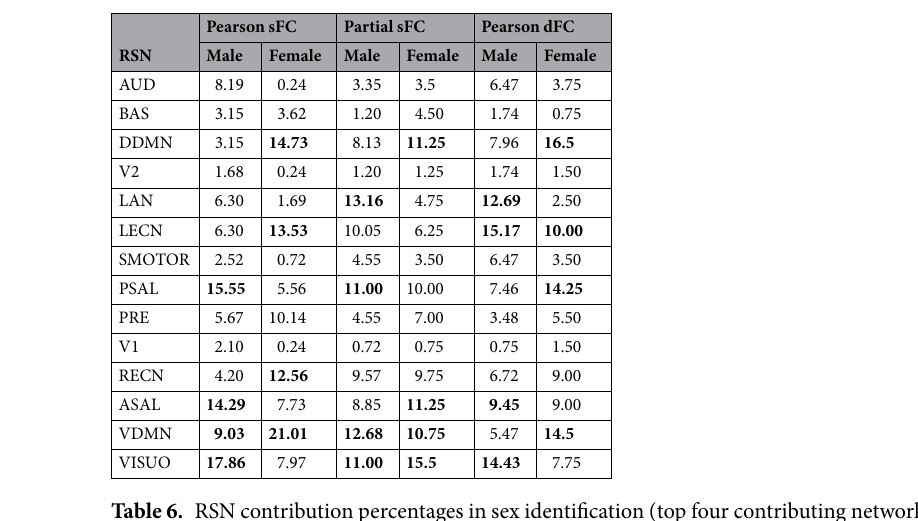
Table 6. RSN contribution percentages in sex identification (top four contributing networks highlighted in bold font). AUD-Auditory, BAS-Basal Ganglia, DDMN-Dorsal Default Mode Network, V2-Primary Visual, LAN-Language, LECN-Left Executive Control Network, SMOTOR-Sensorimotor, PSAL-Posterior Salience, PRE-Precuneus, V1-High Visual, RECN-Right Executive Control Network, ASAL-Anterior Salience, VDMN- Ventral Default Mode Network,